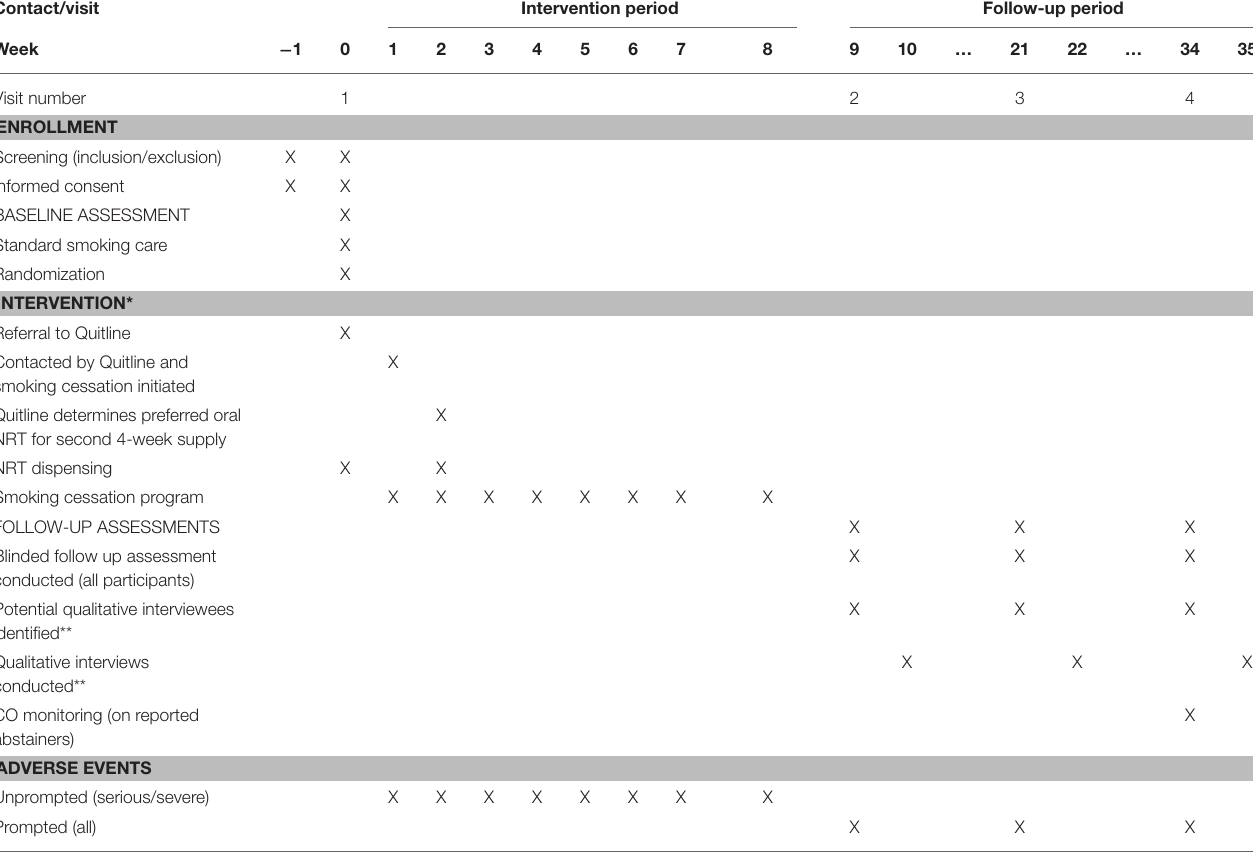
TABLE 2 | Stepwise procedures. Contact/visit Intervention